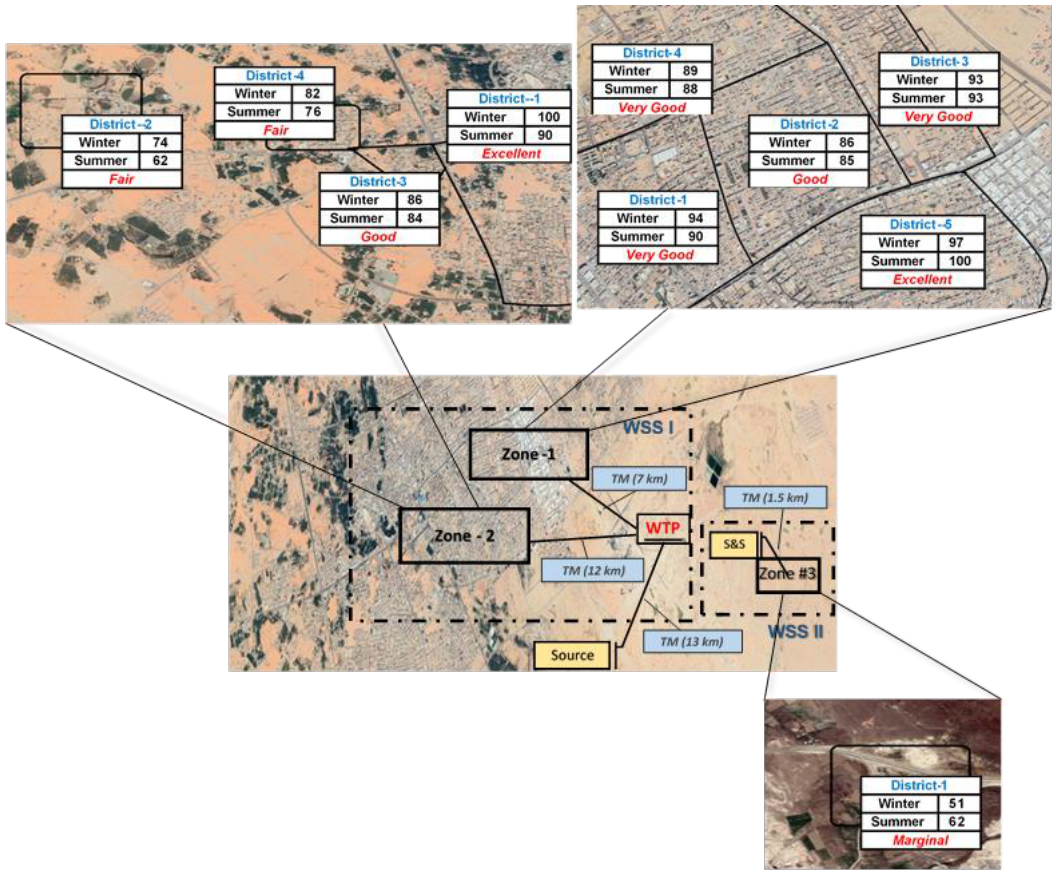
Figure 6. Vignette showing spatial water quality variations in WSS I and WSS II of the study area. [Abbreviations: Transmission Main (TM), Water supply system (WSS), Water Treatment Plant (WTP),